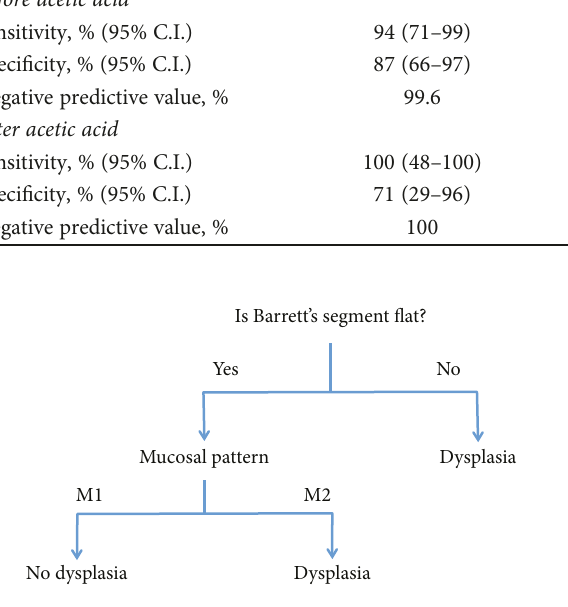
Figure 3: Decision tree constructed from expert opinion that was used to train non-expert endoscopists. M1: regular circular (oval) or villous/gyrus ridged pits; M2: distorted irregular pits or featureless mucosa. Flat means absence of endoscopically visible nodularity or ulceration.